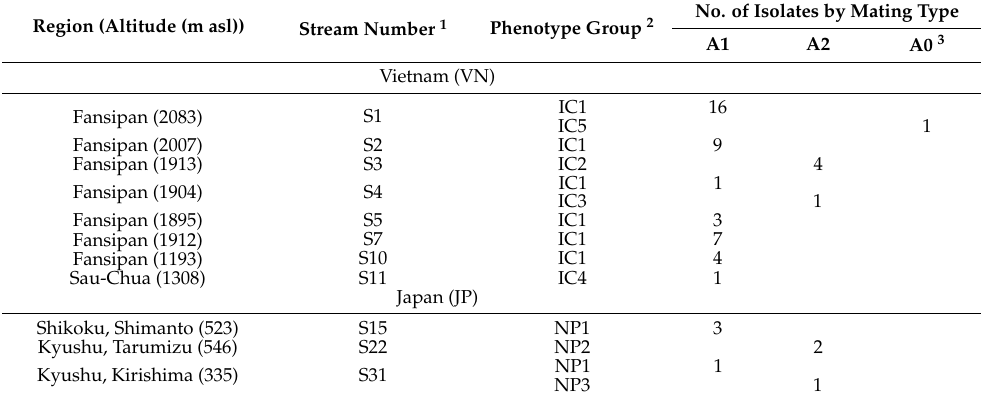
Table 2. Distribution of phenotype groups and mating types of Phytophthora ramorum across stream catchments in Vietnam and